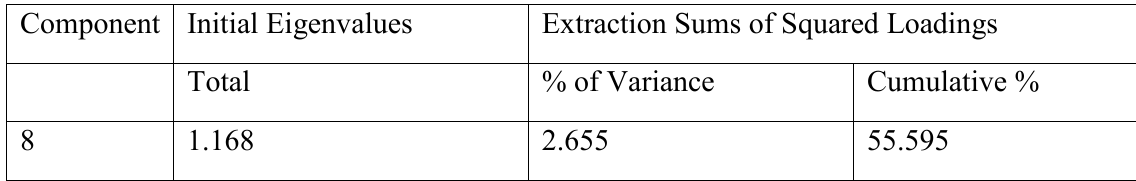
Table 1.15: Variance explained for Absorptive Resilience PC8